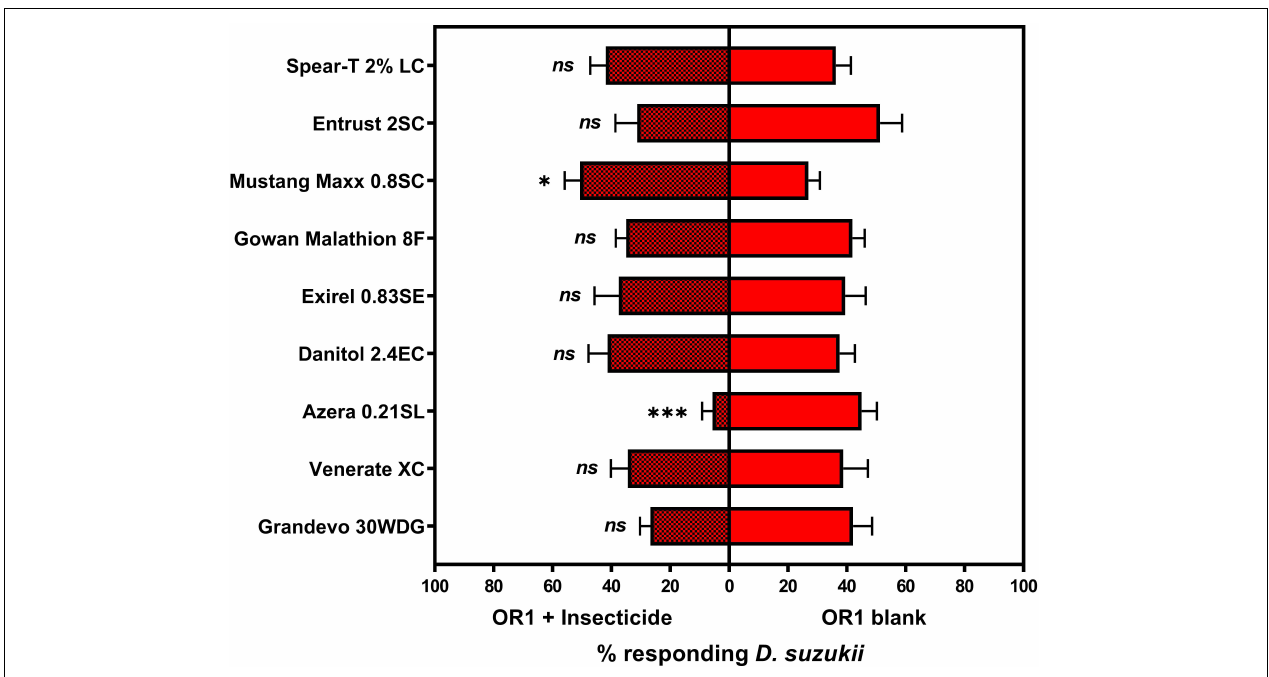
FIGURE 3 | Mean ( ± SEM) percent of total Drosophila suzukii released in an arena captured inside the traps contains an ACTTRA SWD OR1 + insecticide treatment vs. trap containing blank ACTTRA SWD OR1. “ ns ,” no statistical difference (paired t -test; α = 0.05); significant difference, ∗ P < 0.05 and ∗∗∗ P < 0.001. For OR1 + Grandevo 30WDG vs. OR1 blank: N = 8, df = 7, t = 1.732, P = 0.1268; OR1 + Venerate vs. OR1 blank: N = 8, df = 7, t = 0.351, P = 0.7362; OR1 + Azera 0.21SL vs. OR1 blank: N = 8, df = 7, t = 6.323, P < 0.0004; OR1 + Danitol 2.4EC vs. OR1 blank: N = 8, df = 7, t = 0.330, P = 0.7512; OR1 + Exirel 0.83SE vs. OR1 blank: N = 8, df = 7, t = 0.132, P = 0.8985; OR1 + Gowan Malathion 8F vs. OR1 blank: N = 8, df = 7, t = 0.925, P = 0.3860; OR1 + Mustang Maxx 0.8SC vs. OR1 blank: N = 8, df = 7, t = 3.397, P = 0.0115; OR1 + Entrust 2SC vs. OR1 blank: N = 8, df = 7, t = 1.402, P = 0.2037; and OR1 + Spear-T 2% LC vs. OR1 blank: N = 8, df = 7, t = 0.583, P =